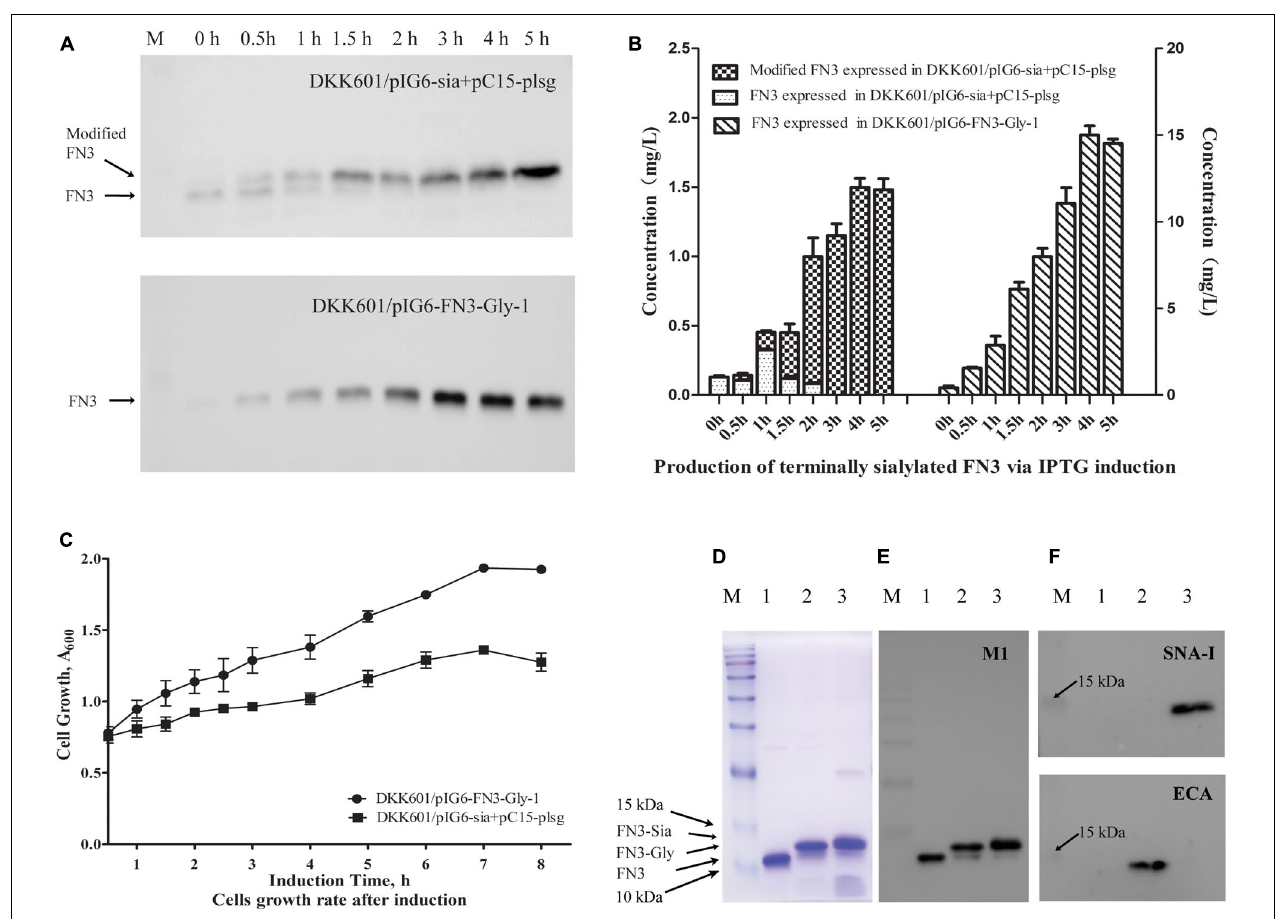
FIGURE 2 | Production of terminally sialylated homogeneous N -glycosylated FN3 in the E. coli periplasm. (A) Western-blot analysis of the expression of modified FN3. E. coli cell lysates containing pIG6-Sia + pC15-plsg (upper panel) or pIG6-FN3-Gly-1 plasmids (lower panel) were detected at the indicated induction time points using anti-FLAG M1 antibody, with quantification of protein yields at different induction time points to determine optimal expression conditions (For detailed information, see Supplementary Figures 3, 4 ) (B) . (C) Growth curves of E. coli DKK601/pIG6-FN3-Gly-1 (expressing FN3 protein without sialylation pathway) and E. coli DKK601/pIG6-Sia + pC15-plsg (expressing modified FN3 protein with sialylation pathway) cells after induction of recombinant protein expression and glycosylation. Purified unmodified FN3, N -glycosylated FN3 (FN3-Gly) and sialylated FN3 (FN3-Sia) produced over 5 h at 28 ◦ C in E. coli DKK601 cells containing the FN3 gene alone; FN3 and lsgCDEF , wecA , pglB and pglK genes for N -glycosylation (FN3-Gly) (Ding et al., 2017); or additional neuBCA and pl- ST6 genes to effect sialylation (FN3-Sia), detected by (D) Coomassie-stained SDS-PAGE, (E) Western blotting using anti-FLAG M1 antibody, and (F) lectin blotting